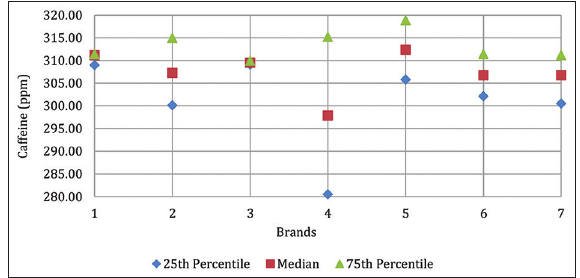
FIGURE 2: The caffeine content in energy drinks